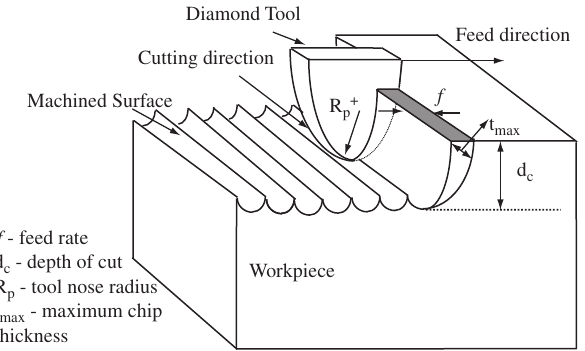
Figure 1. Schematic diagram illustrating machining geometry with round nose